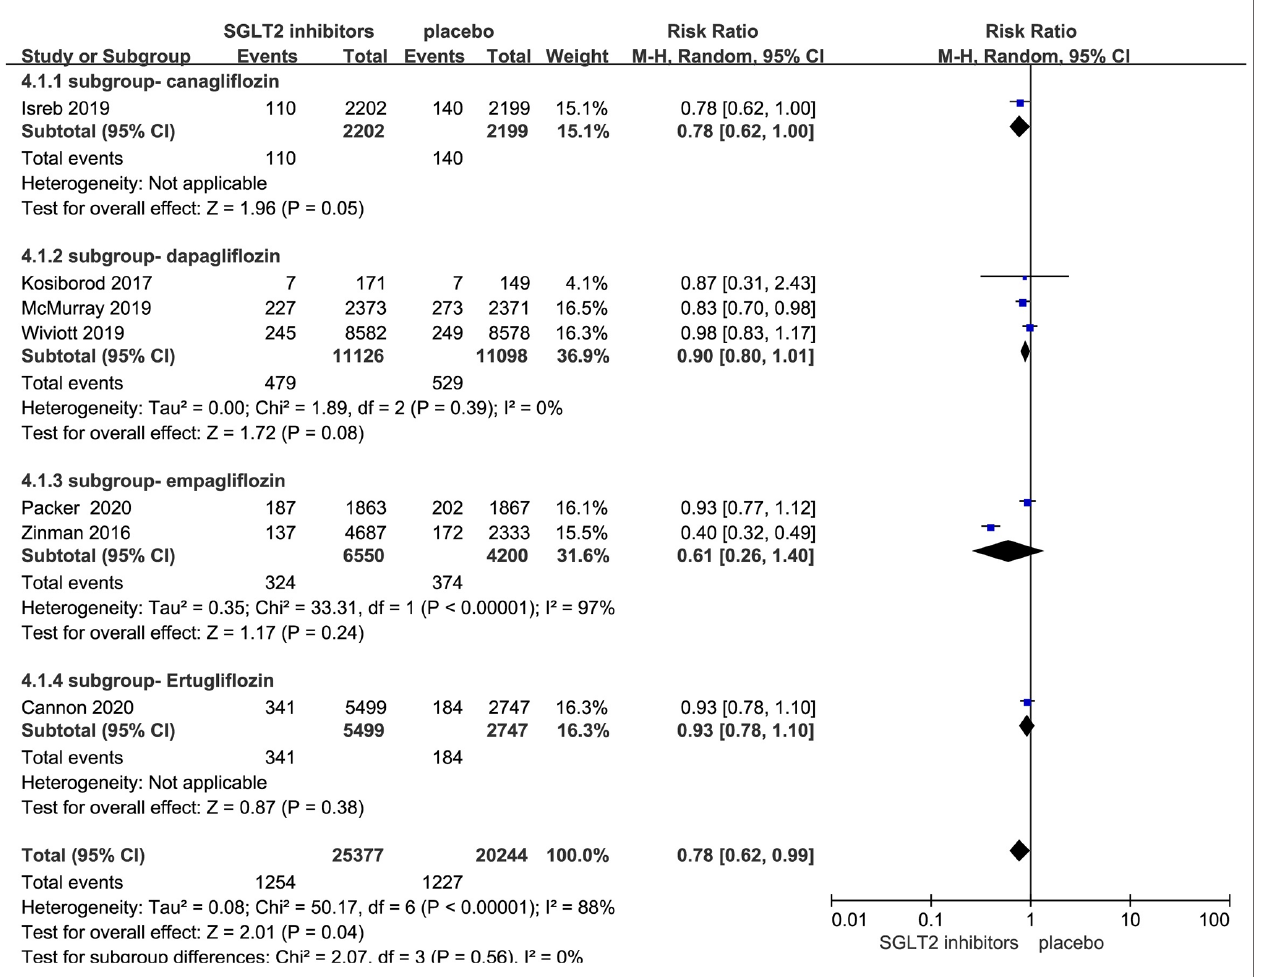
FIGURE 4 | Cardiovascular death in type 2 diabetes patients receiving SGLT2 inhibitors versus